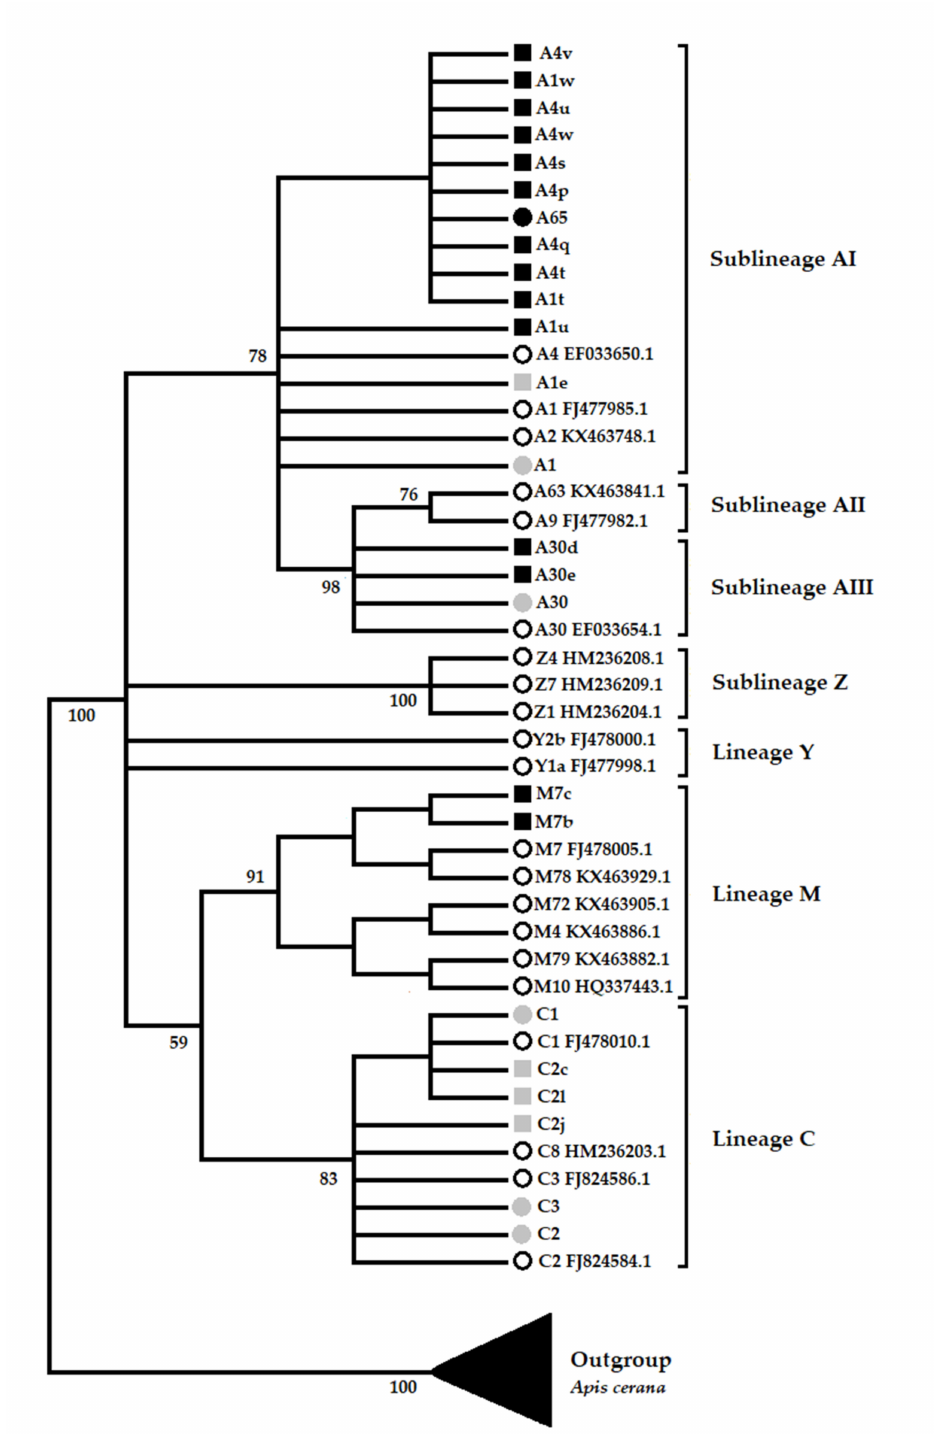
Figure 3. Phylogenetic relationships of haplotypes identified for Peruvian honey bee populations. Sub-lineages A I , A II , A III , and Z belong to the African lineage. Nodes are supported by 1000 bootstraps. Black circles indicate novel haplotypes, light gray circles indicate haplotypes previously reported and found in this study, black squares indicate novel variants, light gray squares indicate variants reported by others and in this study, and white circles indicate reference haplotypes obtained from